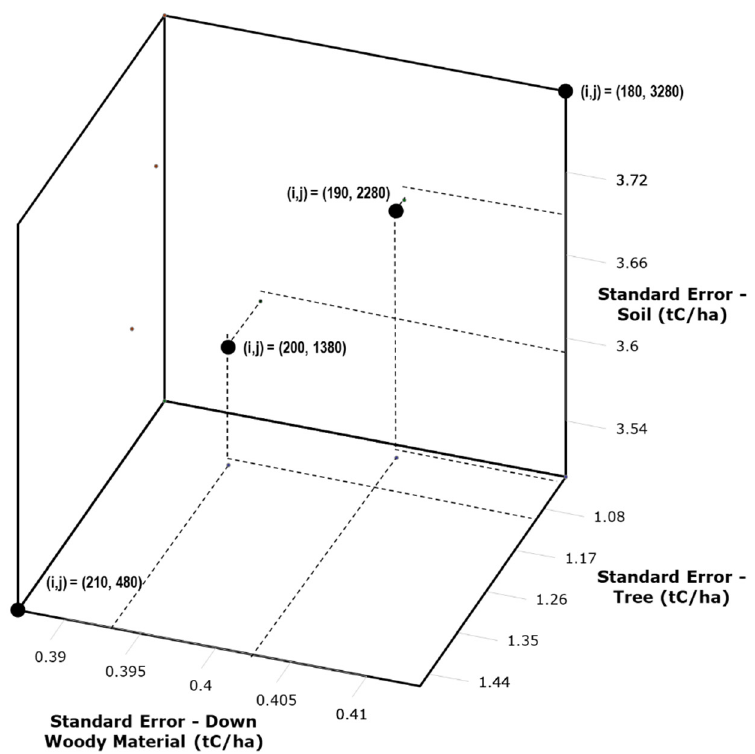
Figure 2. Pareto optimal sampling intensity combinations for field and lidar plots with projected standard errors in tree carbon, down woody material carbon, and soil carbon .